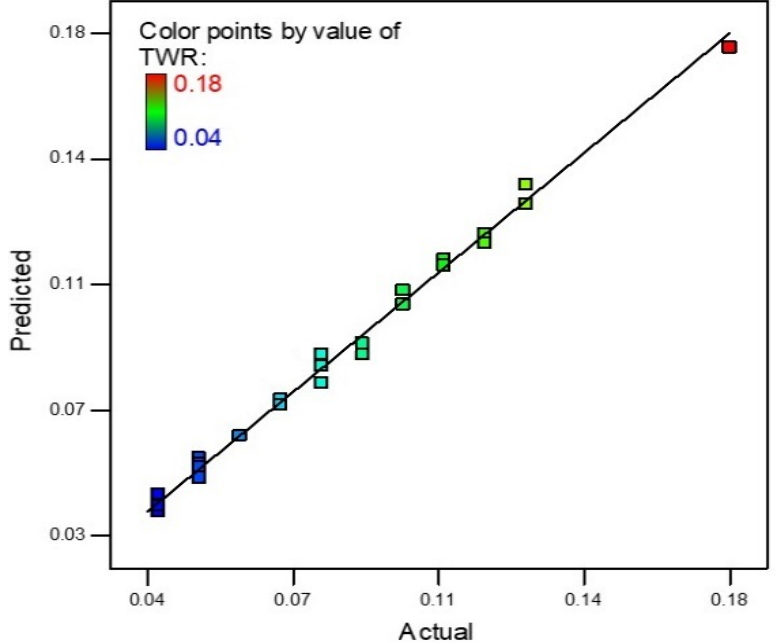
Figure 4. TWR Predicted vs. actual values. Table 7. TWR results by using different